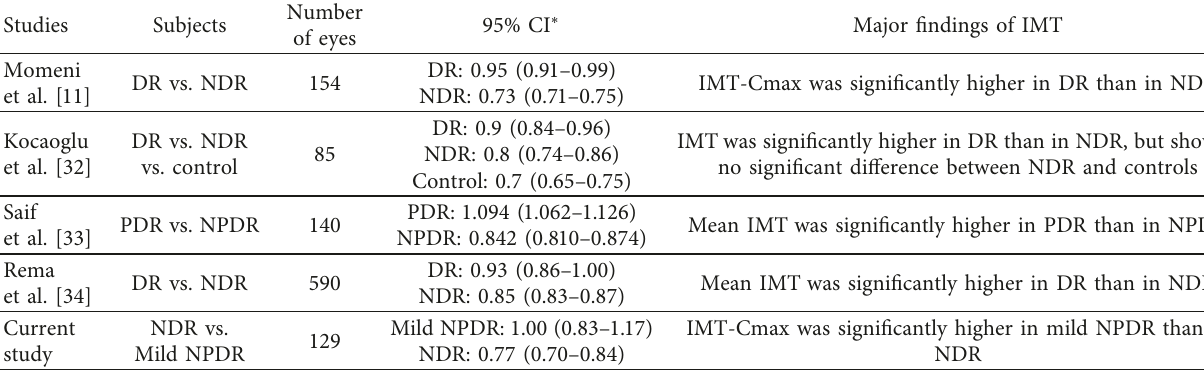
Table 3: Comparison of previous